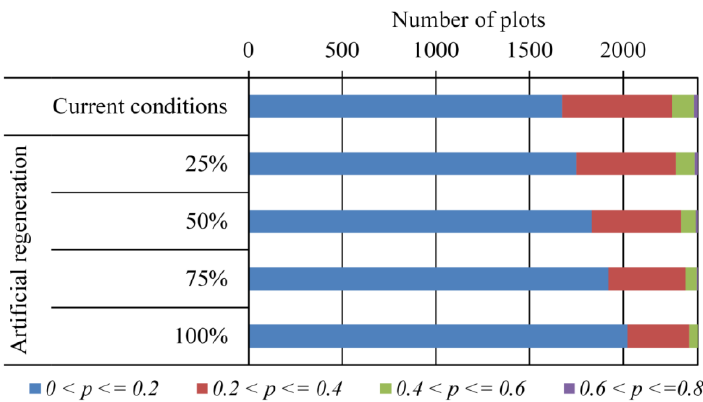
Figure 4. Number of plots within the indicated categories of estimated probability ( p ) of invasion (blue: 0 < p ď 0.2, red: 0.2 < p ď 0.4, green: 0.4 < p ď 0.6, purple: 0.6 < p ď 0.8) by Japanese honeysuckle assuming current conditions, and artificial regeneration on 25%, 50%, 75%, or 100% of the plots (chosen at random).